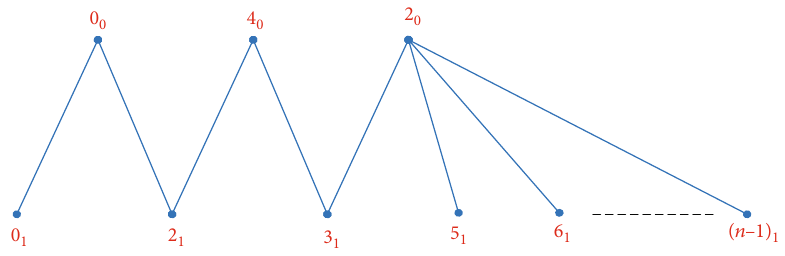
ð 1, 0, 0, n − 4 Þ . 4